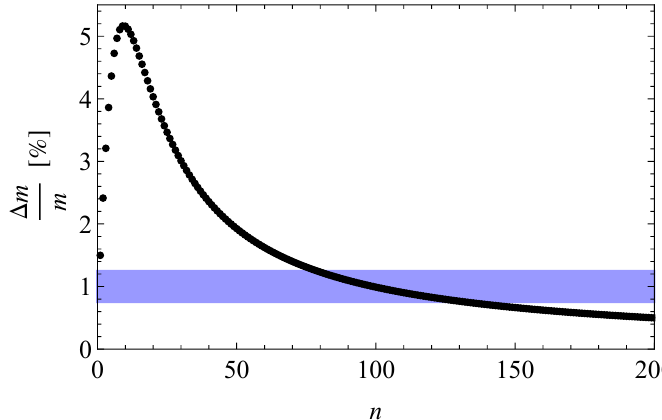
Figure 2 . KK graviton mass splittings as a function of the mode number. The behavior is shown for M 5 = 10 TeV, k = 200 GeV, however the result does not strongly depend on these parameters. The blue band indicates the typical ATLAS and CMS resolutions in the diphoton and dielectron channels ( (cid:25)